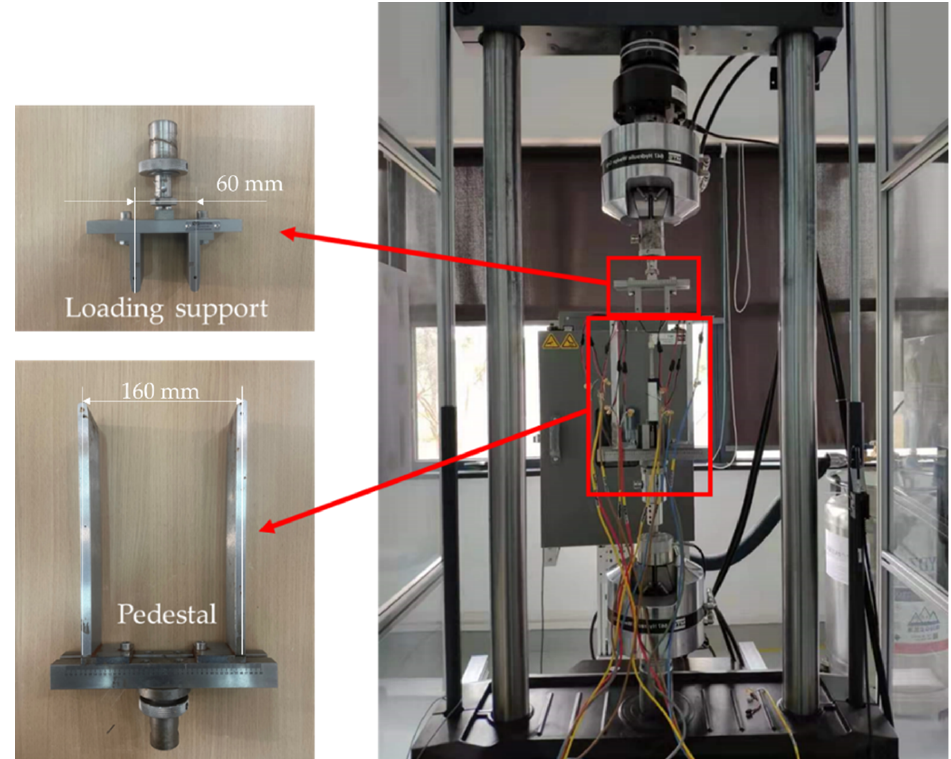
Figure 5. Set-up for the four-point bending test.